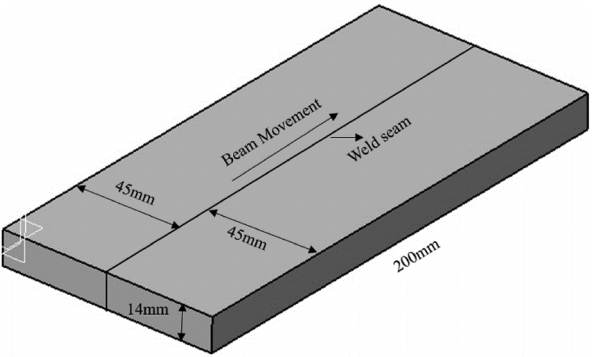
Figure 7: Butt welding plates.